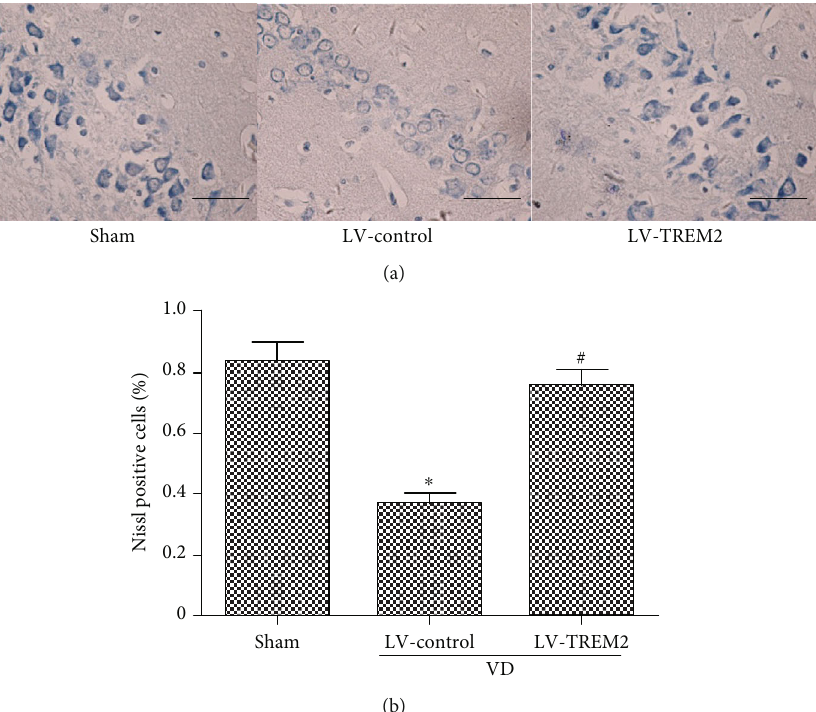
Figure 5: TREM2 overexpression prevents neuronal loss in VD mice. (a) Nissl staining was performed to detect neuronal loss in the hippocampus of VD mice. (b) The percentage of Nissl-positive neurons in the hippocampus of VD mice. Scale bars = 50 μ m . Compared to the sham group, ∗ p < 0 : 05 ; compared to the LV-control group, # p < 0 : 05